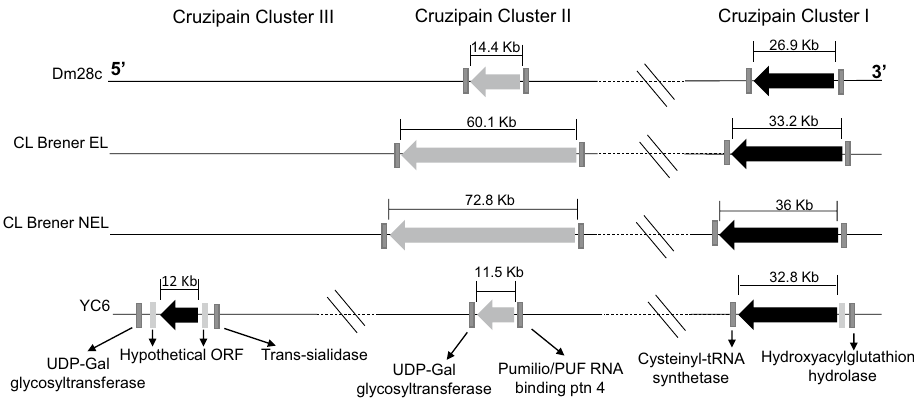
Figure 1. Cruzipain genes from Dm28c (DTU-TcI), CL Brener (DTU-TcVI), and YC6 (DTU-TcII) T. cruzi strains are organized in two or three clusters. Organization of cruzipain gene copies in the T. cruzi genome. The clusters are displayed in the 5 ′ to 3 ′ direction according to the genome localization. Each cluster is represented as a horizontal arrow indicating the translation direction. Dm28c: Dm28c strain; CL Brener EL: CL Brener strain Esmeraldo-like haplotype; CL Brener NEL: CL Brener strain non-Esmeraldo-like haplotype, YC6: Y strain. The flanking genes are shown as rectangles with the functional ORFs in dark gray and the hypothetical ORFs in light gray. The clusters are located in chromosome 6 of the CL Brener and chromosome 35 of the YC6 strain. The chromosome has not been assigned in Dm28c.